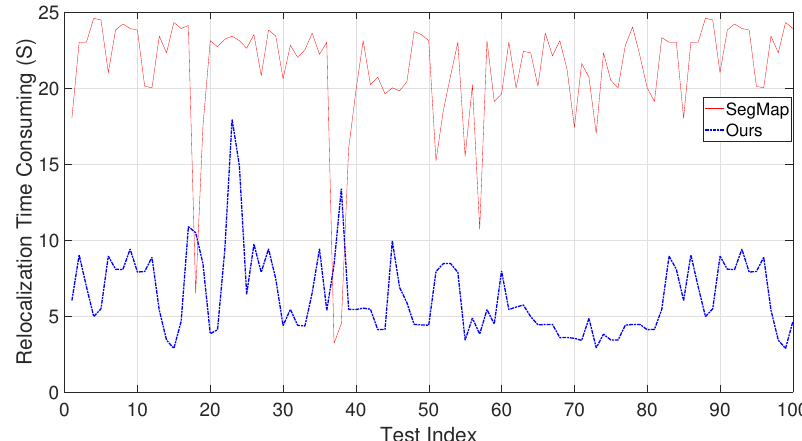
Figure 15. Comparison on the computation time of the entire process on KITTI sequence 00 between SegMap and ours.